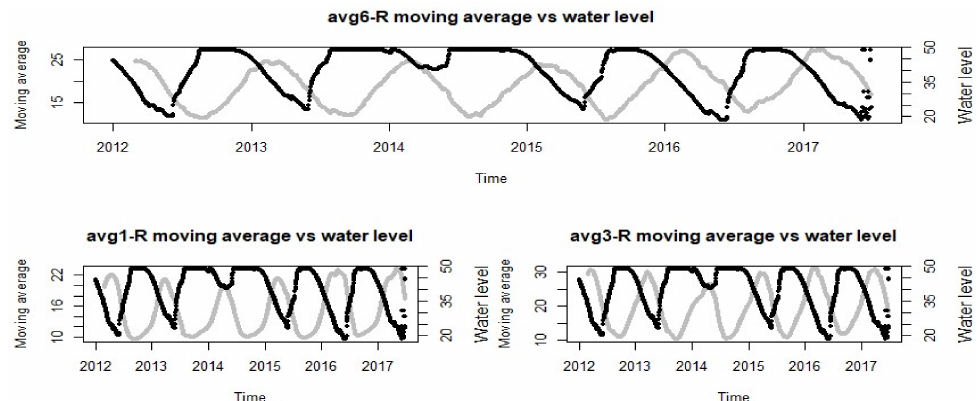
Figure 14. Avg6-R, avg1-R, and avg3-R 60-day moving averages ( ◦ C) (grey) against water level (m) (black).